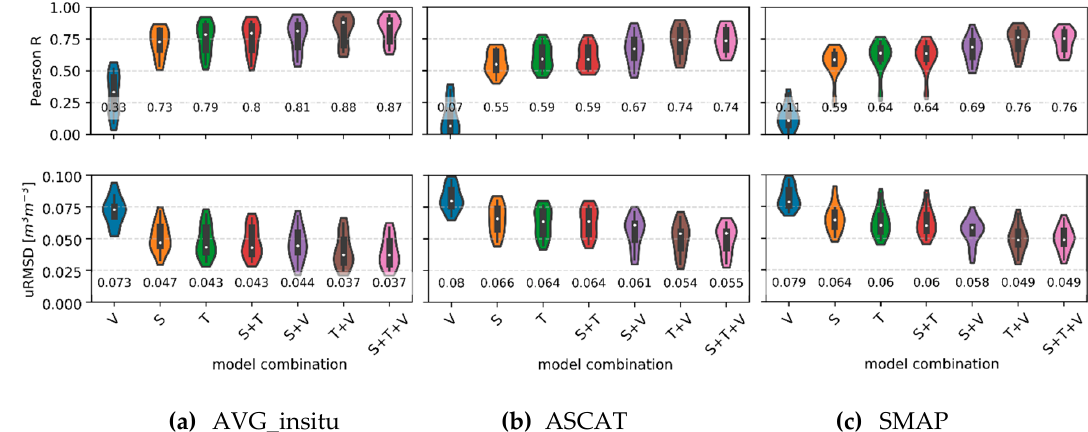
Figure 3. Violin plots of Pearson R (top) and unbiased root mean square deviation (uRMSD) (bottom) between measured and predicted soil moisture (see Table 1). The soil moisture source used as predictor (surface soil moisture (SSM)) is displayed above each graph: AVG_insitu ( a ), ASCAT ( b ), and SMAP ( c ). The different model combinations are reported on the X -axis: S indicates “soil texture”, T indicates “topography”, and V indicates “vegetation”. The boxplots within the violins depict quartiles, and the white dots indicate the median values (also reported below the violins).